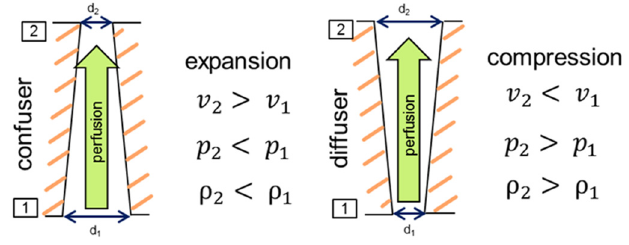
Fig. 5. Comparison between confuser and diffusor.